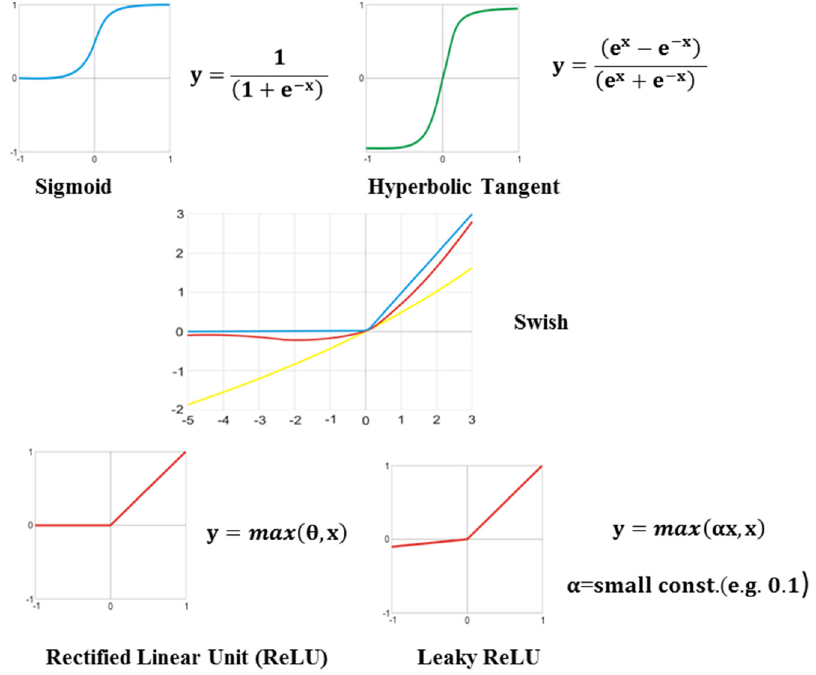
Figure 2. Examples of Activation Functions.